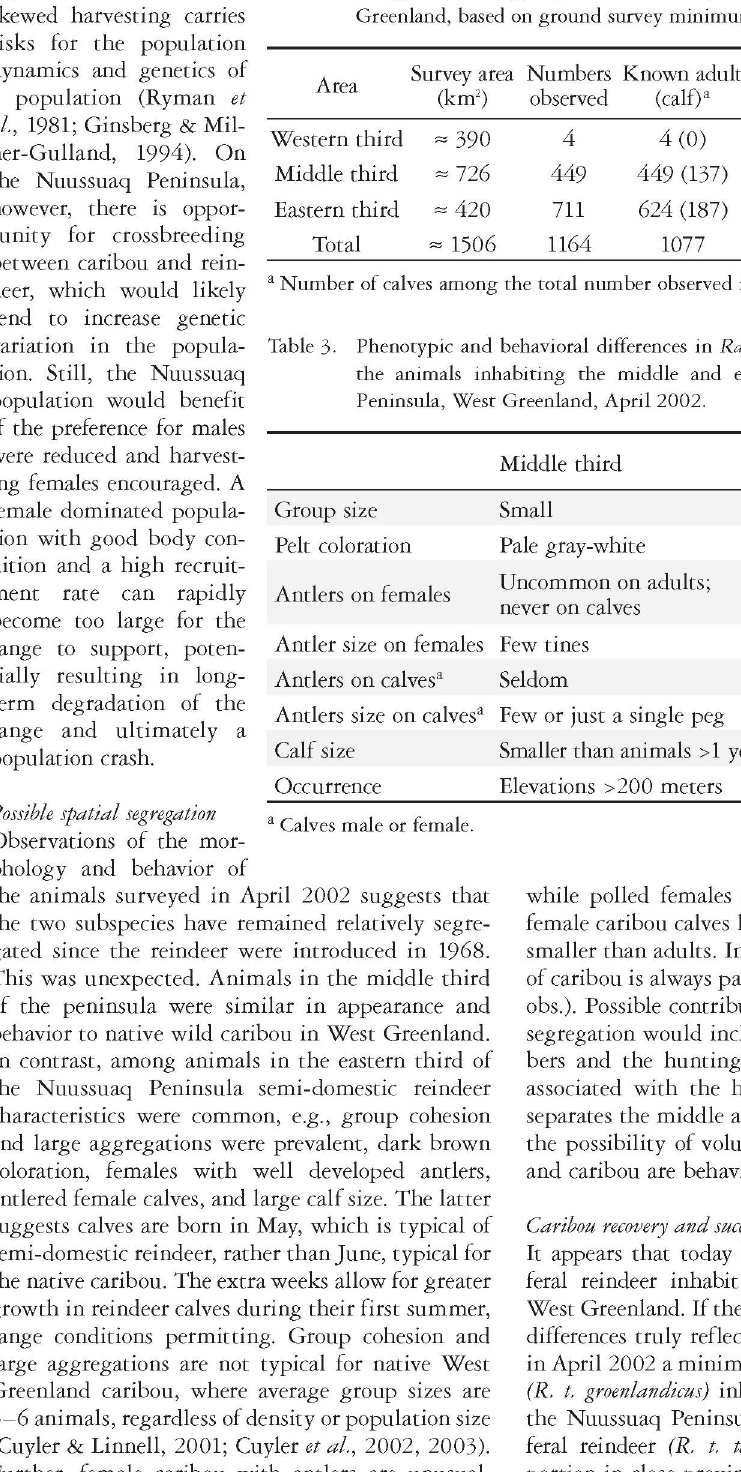
Table 2. Rangifer tarandus group size and density on the Nuussuaq Peninsula, West Greenland, based on ground survey minimum counts of late April 2002.